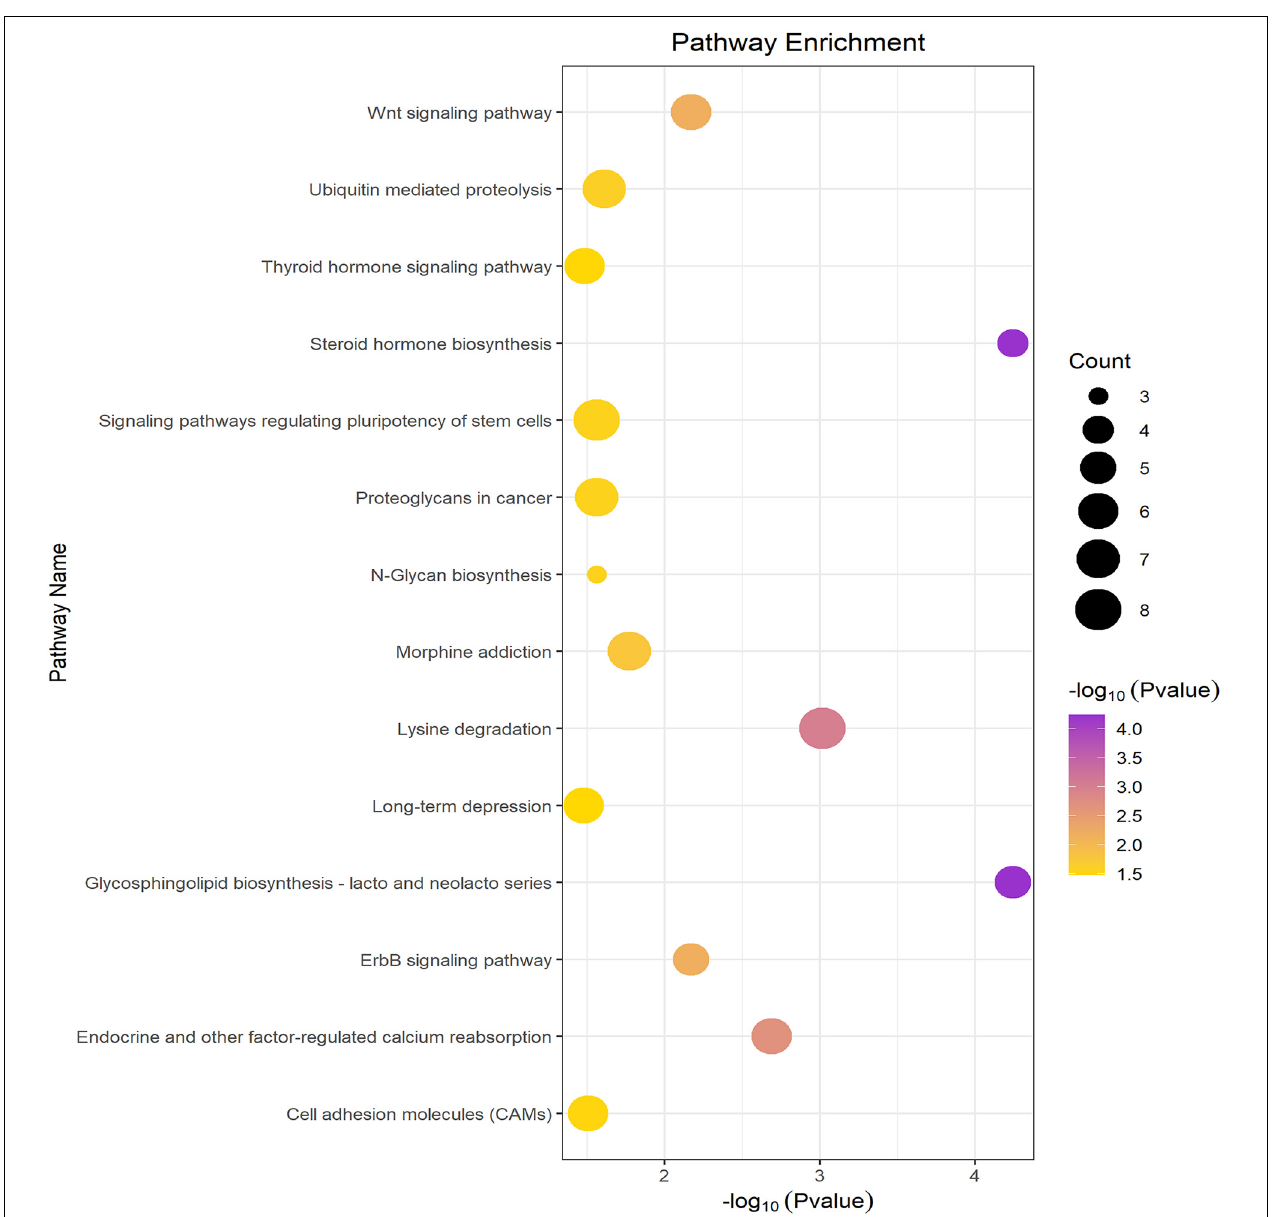
FIGURE 3 | KEGG pathway analysis of top ten